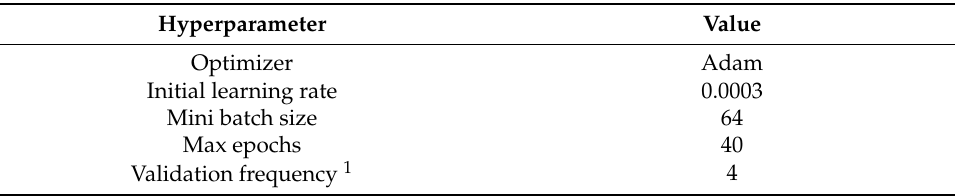
Figure 7. Mel spectrograms drawn from CWRU data: ( a ) Normal; ( b ) OR; ( c ) IR; ( d ) B. Table 3. Fine-tuning